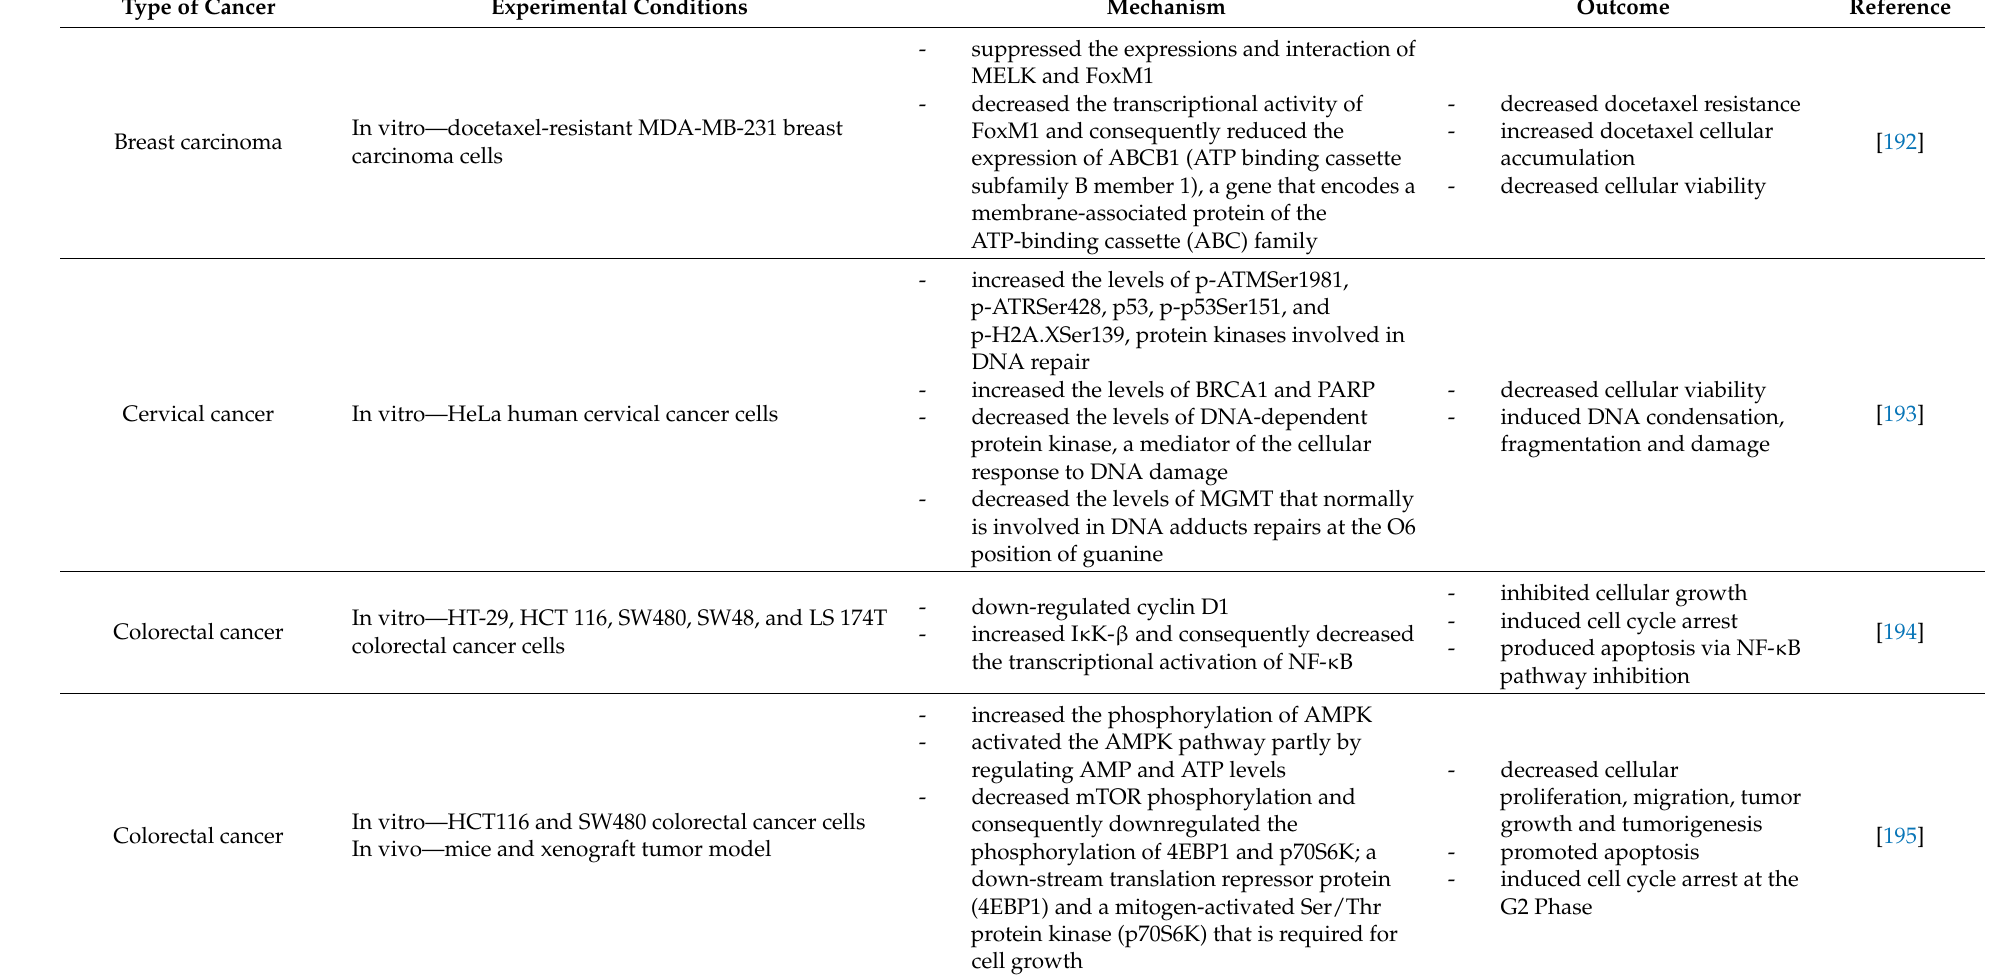
Table 4. In vitro and in vivo biological activity of maslinic acid against different types of